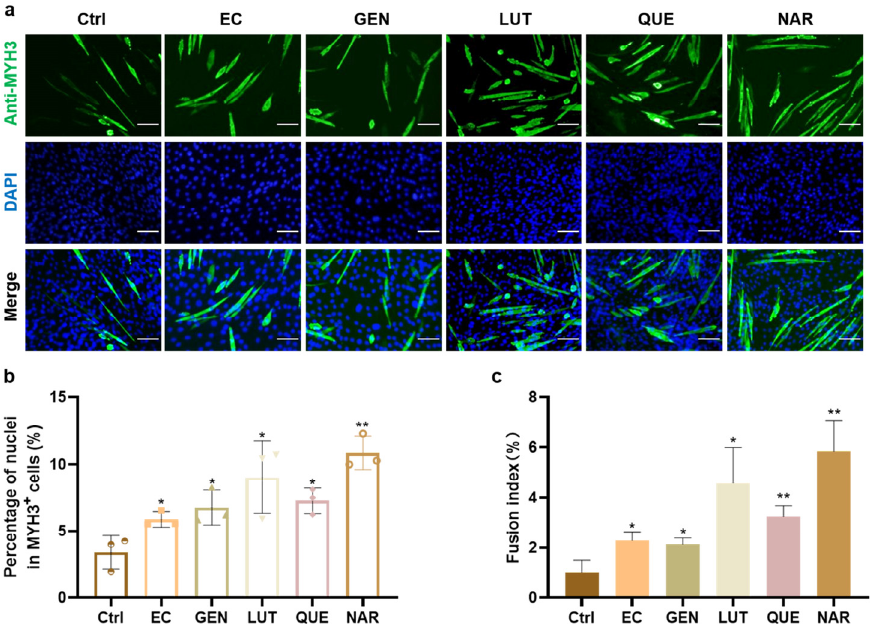
Figure 1. The effect of various flavonoids on myogenic differentiation of C2C12 cells. ( a ) Representative fluorescence images of C2C12 cells after three days of culture in DM alone (Ctrl), or with supplementation of EC (20 µ M), GEN (10 µ M), LUT (10 µ M), QUE (50 nM), or NAR (10 µ M). Green, anti-MYH3; Blue, DAPI, Scale bar, 100 µm. ( b ) The percentage of nuclei in myotubes (MYH3 + cells) to total nuclei according to immunofluorescent images from three random views. ( c ) Fusion index as a percentage according to immunofluorescent images. Error bars represent mean ± SD. The asterisk indicates a significant difference between ctrl and the treatment group. * p < 0.05, ** p < 0.01.